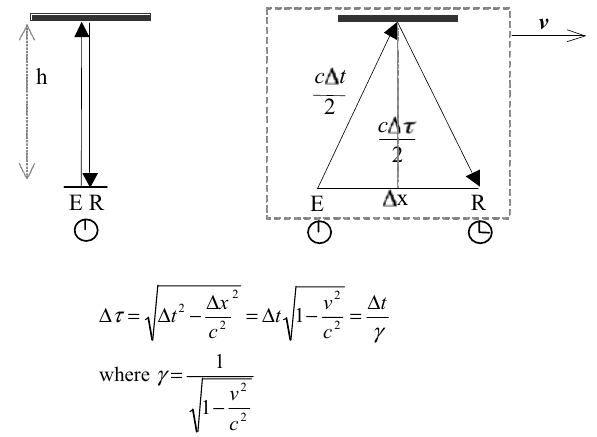
FIG. 2. The light clock